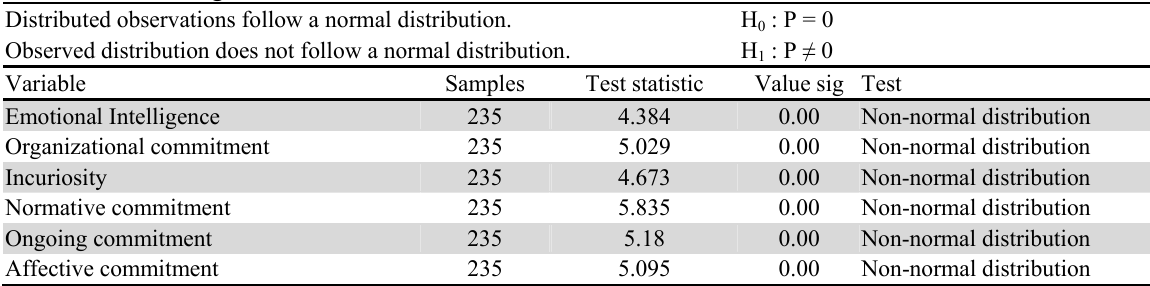
Test of the Kolmogorov - Smirnov Distributed observations follow a normal distribution.